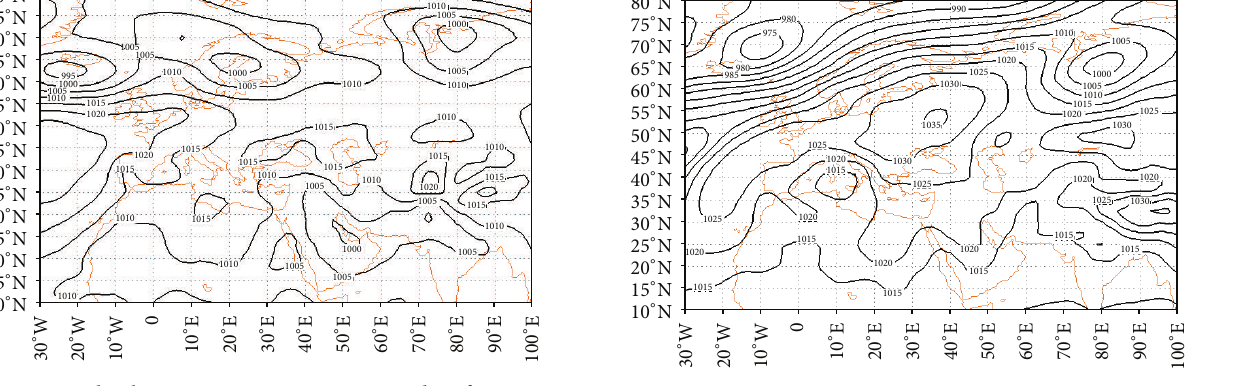
Figure 33: Sea level pressure map in representative day of pattern